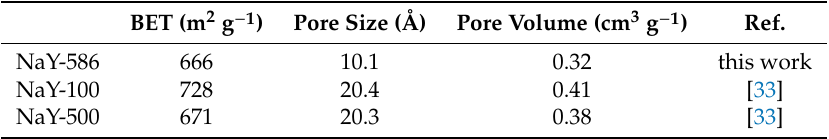
Table 2. Comparison of BET surface area, pore size, and pore volume of NaY.